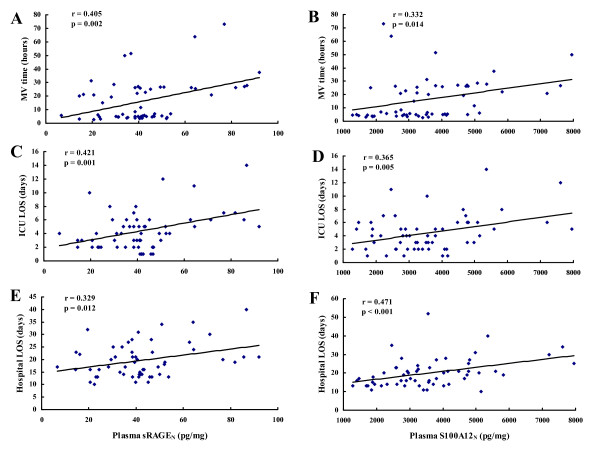
Scatterplot displaying the relation between plasma sRAGEN and S100A12N levels immediately after CPB and the clinical outcomes. The mechanical ventilation time (A, B), the ICU LOS (C, D), and the hospital LOS (E, F) are shown.